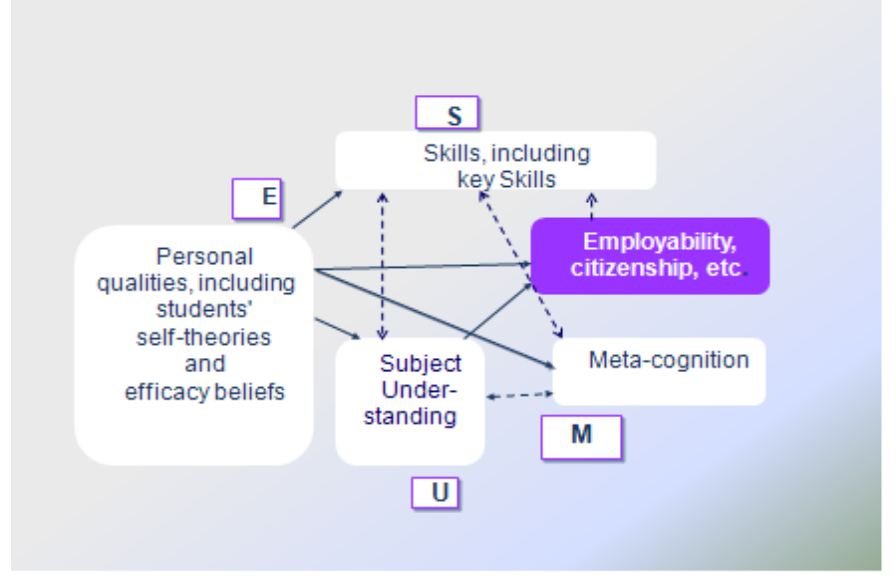
Figure 3. USEM model (Knight & Yorke, 2003, p.